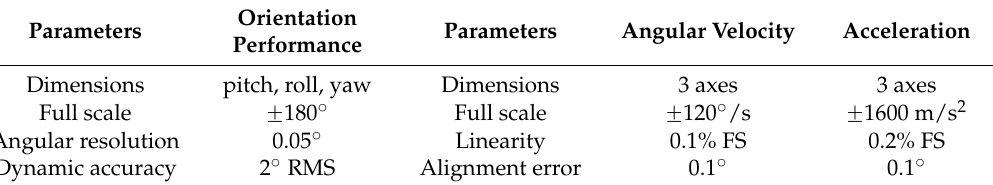
Table 2. Main technical specifications of the